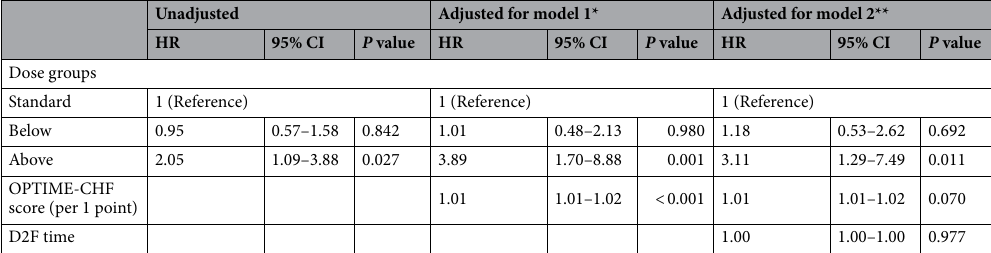
Table 4. Cox proportional hazard analysis for 60-day mortality according to initial furosemide dose groups. *Adjusted for the OPTIME-CHF score and log-transformed brain natriuretic peptide. **Adjusted for Model 1 plus door to furosemide time, dobutamine use within 48 h, dopamine use within 48 h, norepinephrine use within 48 h, phosphodiesterase III inhibitor use within 48 h, vasodilator use within 48 h, total furosemide used within 48 h, and angiotensin-converting enzyme inhibitor/angiotensin II receptor antagonist use within 48 h. CI confidence interval, D2F door to furosemide, HR hazard